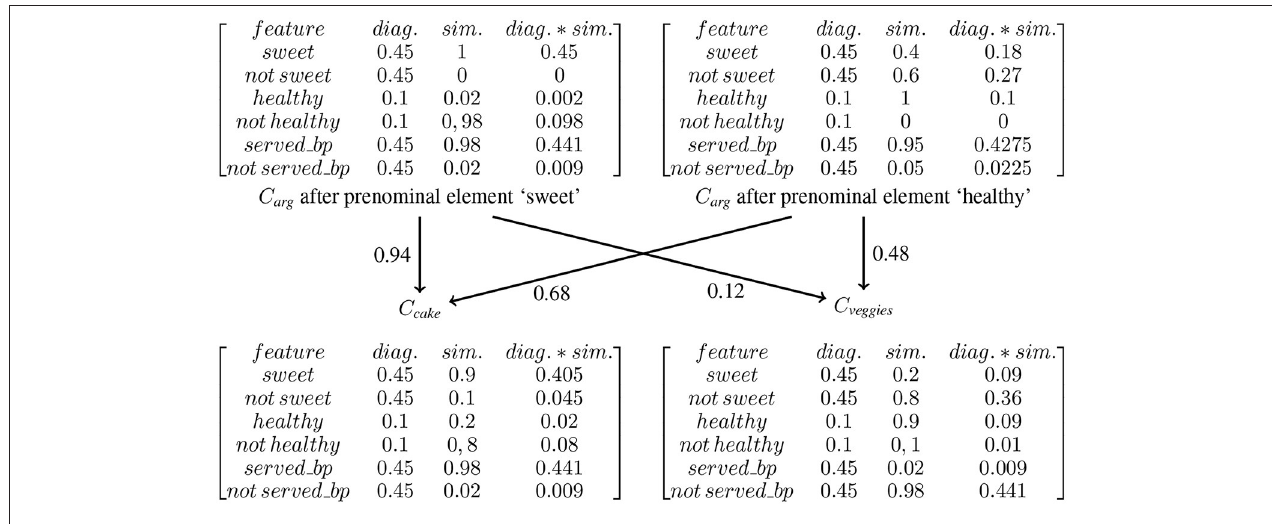
FIGURE 1 | Overview of the diagnosticity, similarity, and typicality values for the four examples in (29). The arrows are labeled by the typicality